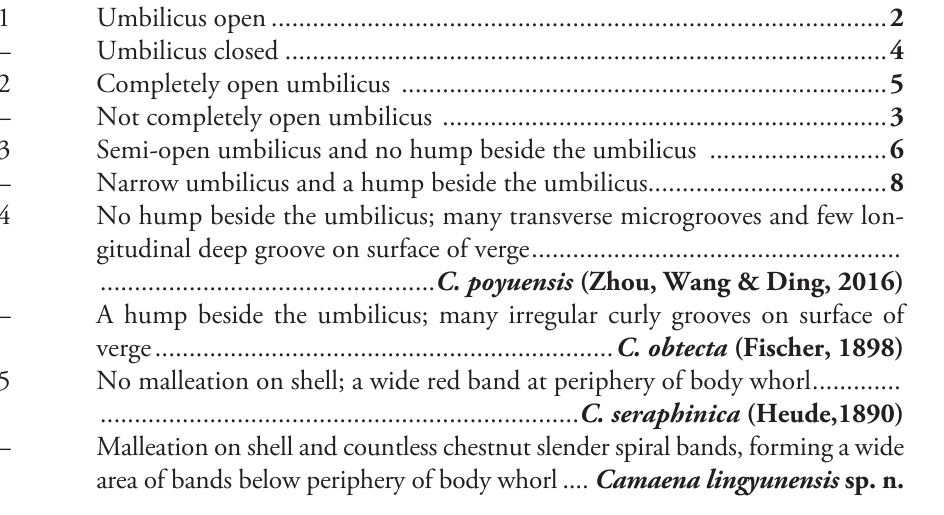
area of bands below periphery of body whorl .... Camaena lingyunensis sp. n.